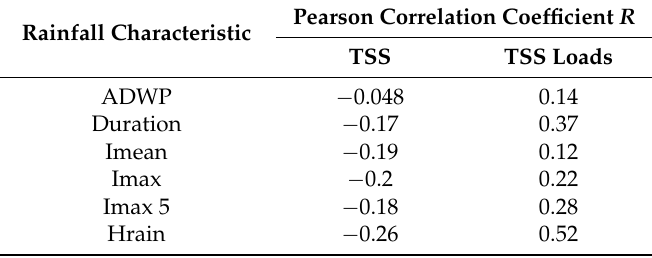
Table 7. Pearson correlation coefficients R between EMC and loads of TSS and rainfall characteristics. Rainfall